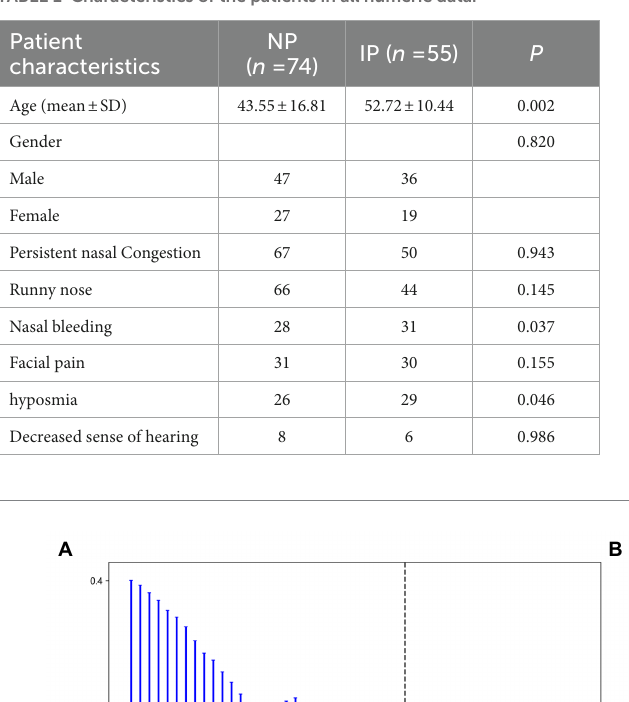
TABLE 1 Characteristics of the patients in all numeric